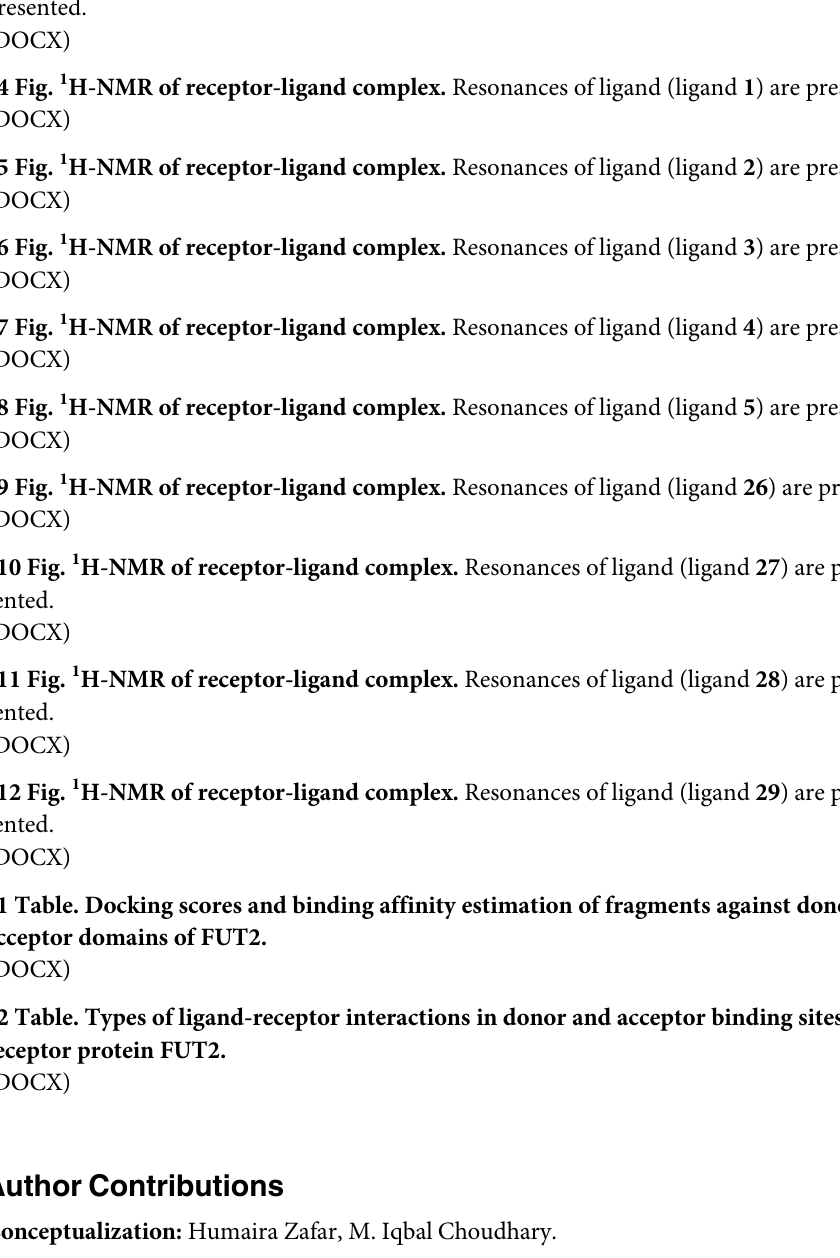
S2 Fig. 1 H-NMR of receptor-ligand complex. Resonances of ligand (GDP-Fucose) are pre- sented. (DOCX) S3 Fig. 1 H-NMR of receptor-ligand complex. Resonances of ligand ( N -Ethylmaleimide) are presented.